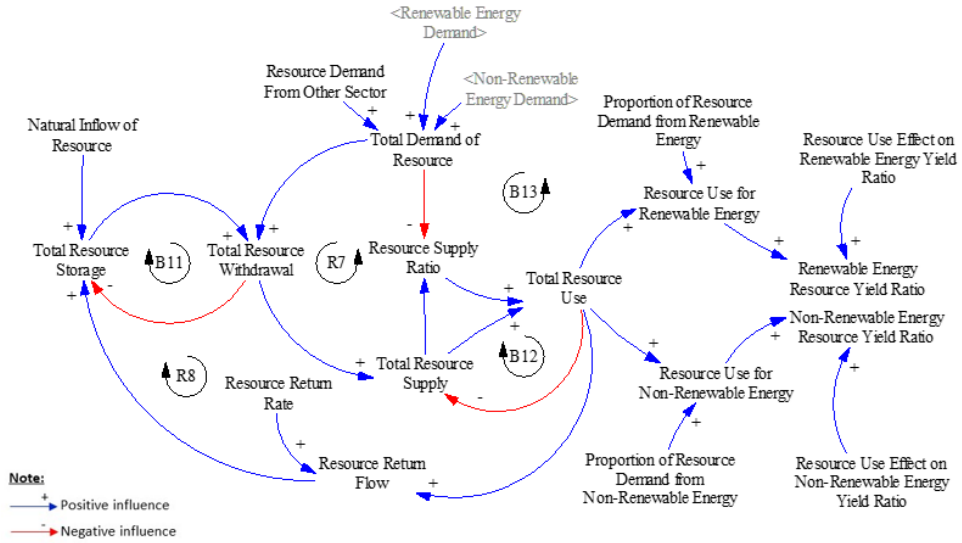
Figure 3. Environmental capacity linked to the supply of non-renewable energy and renewable energy. Blue arrows are paired with (+) sign to indicate positive influence on the variable; red arrows paired with (-) indicate negative influence.